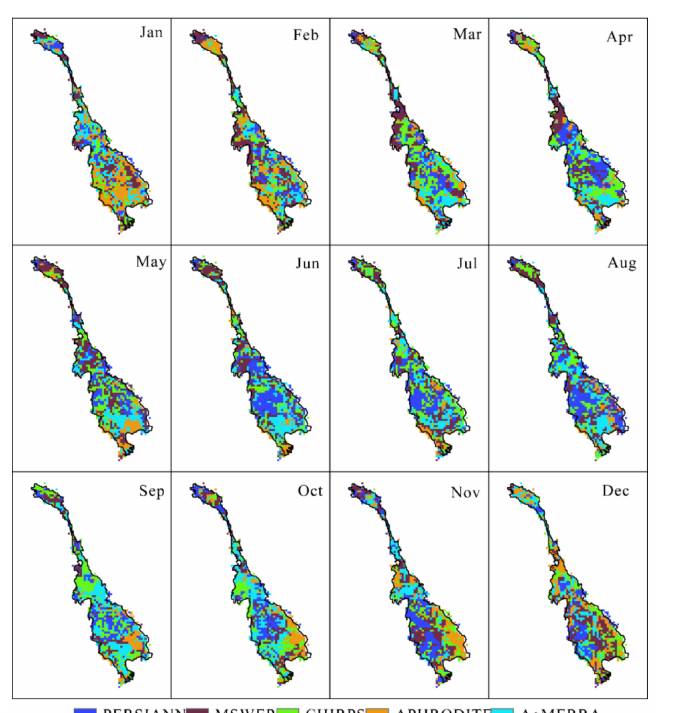
Figure 7. Monthly minimum ME for five precipitation products against inverse distance weighted (IDW)-derived gauge observation during 1998 to